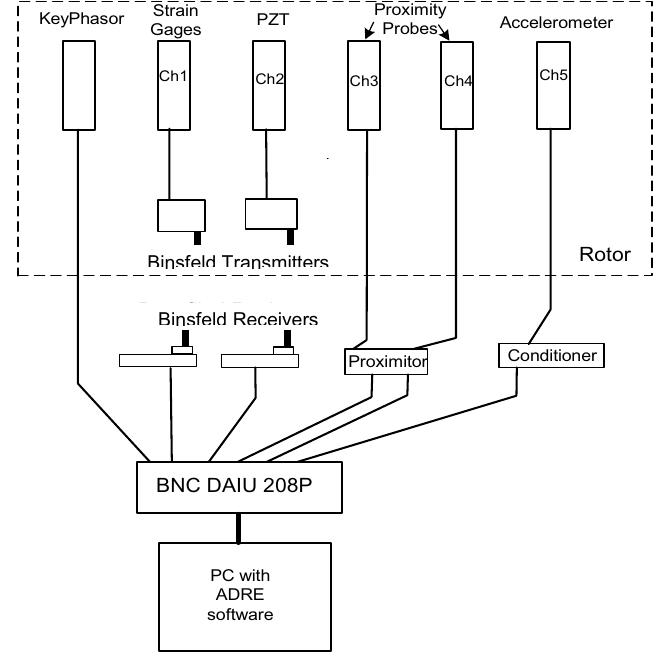
Fig. 28. Schematic of the vibration measurement